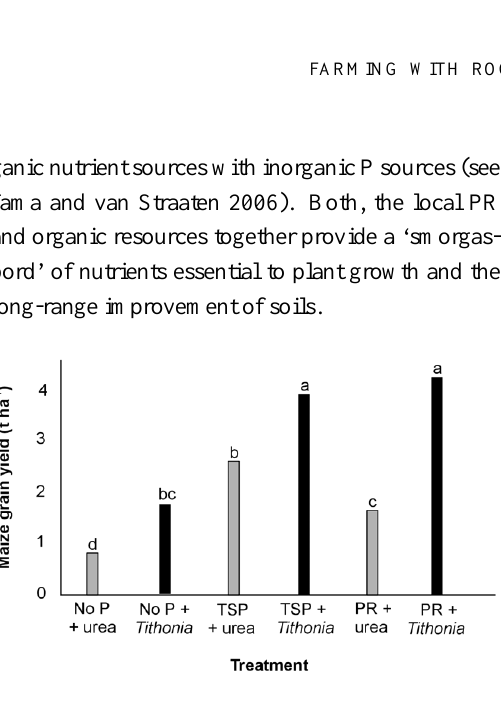
Fig. 2 – Maize grain yield responses to P and N applications on anacidsoilinwesternKenya. PwasprovidedintheformsofTSP and Minjingu PR at a rate of 250 kg P ha -1 respectively, N was provided as urea and as locally available green foliar biomass of Tithoniadiversifolia atarateof60kgha -1 . Blanketapplicationof 60 kg K/ha was added to each crop. Means in a column followed by the same letter are not significantly different at the P = 0.05 level by the LSD test. Source: Sanchez et al.